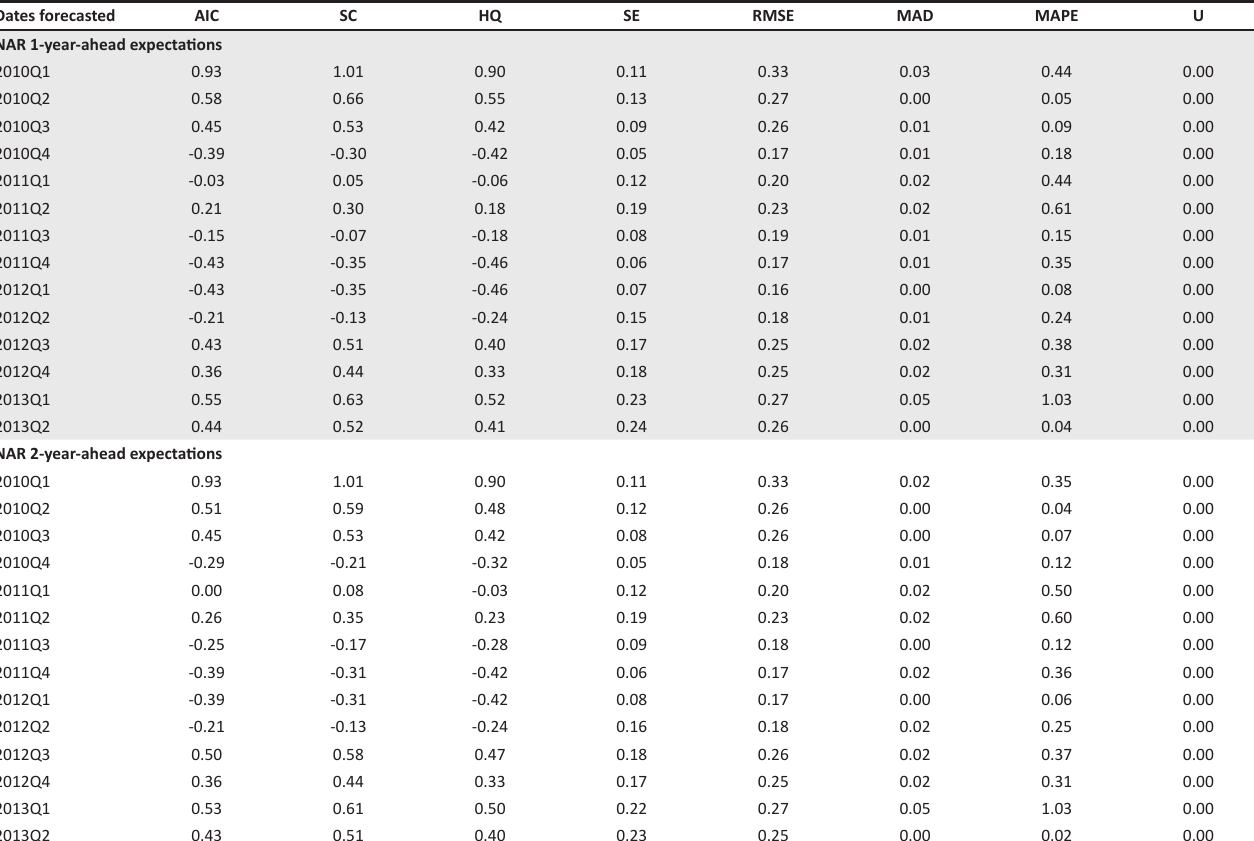
TABLE 2-A1: Inflation accuracy comparison with Bureau for Economic Research and South African Reserve Bank – Quarterly approach (cont.). Dates forecasted AIC SC HQ SE RMSE MAD